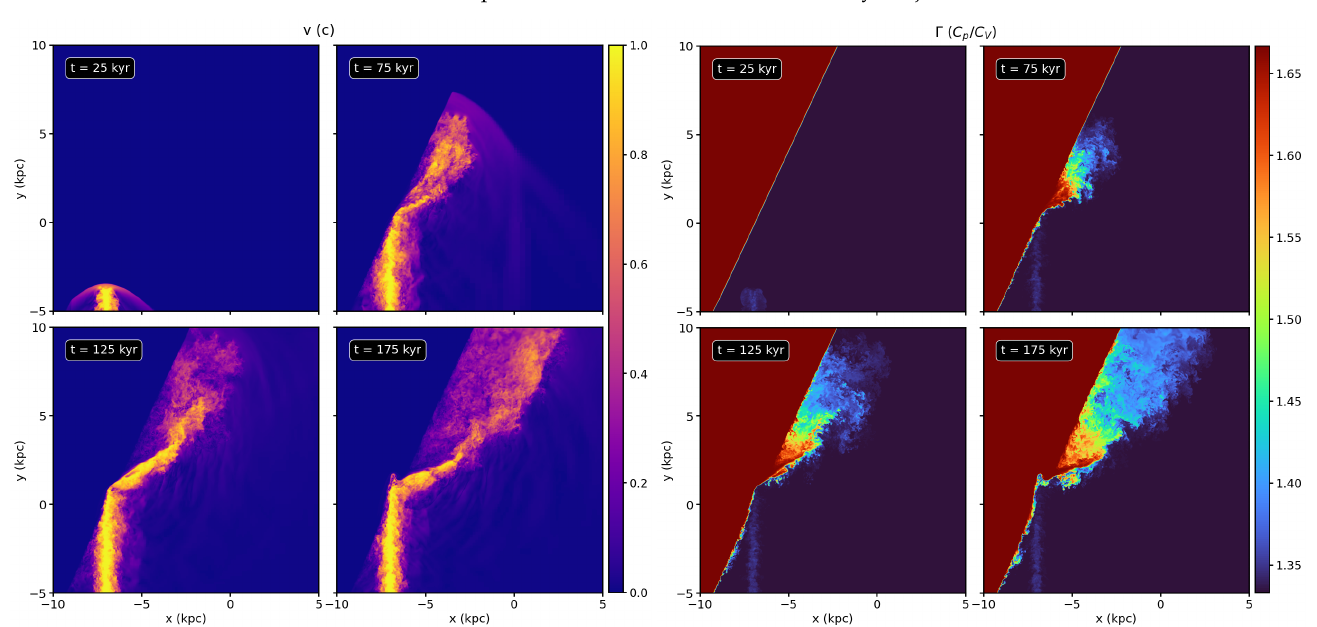
Figure 3. Density ( left ) and pressure ( right ) slices through the center of the simulation domain for the “fiducial” simulation, at four different epochs. Each panel is 15 kpc on a side, zoomed in slightly to focus on the parts of the simulation most affected by the jet.